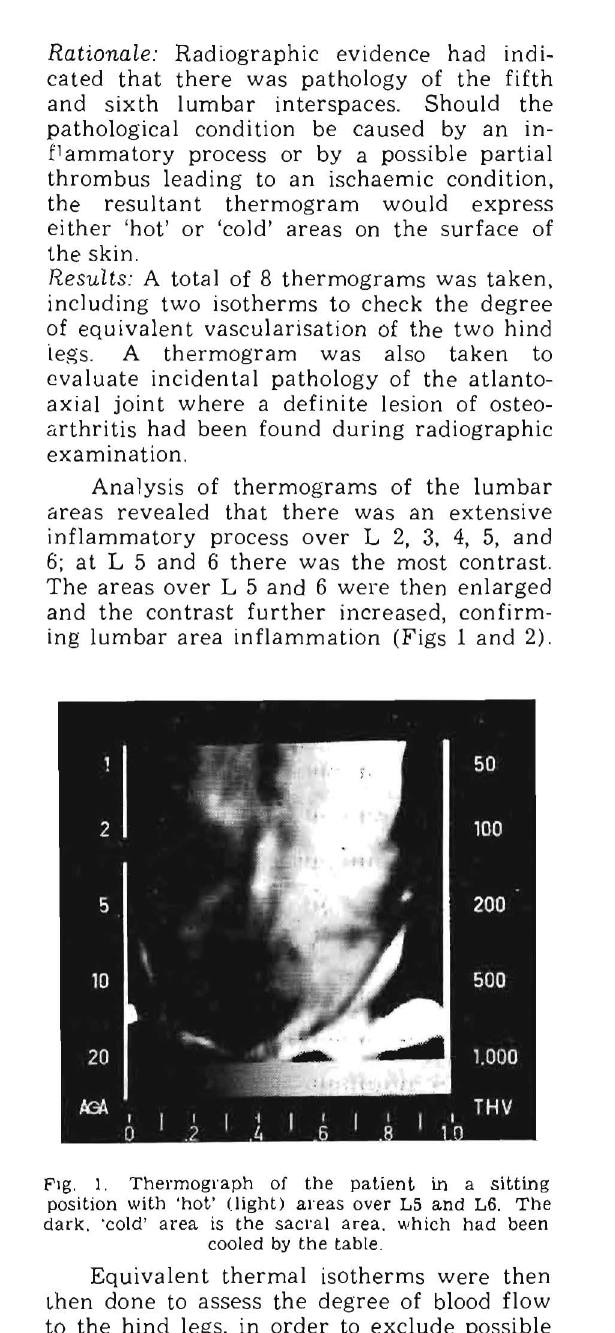
FIg. 1. Thermograph of the patient in a sitting position with 'hot' (light) areas over L5 and L6. The dark. 'cold' area is the sacral area. which had been cooled by the table. Equivalent thermal isotherms were then Lhen done to assess the degree of blood flow to the hind legs, in order to exclude possible iliac thrombosis. The isotherms showed that both legs were well vascularized and there was no iliac thrombosis (Fig.